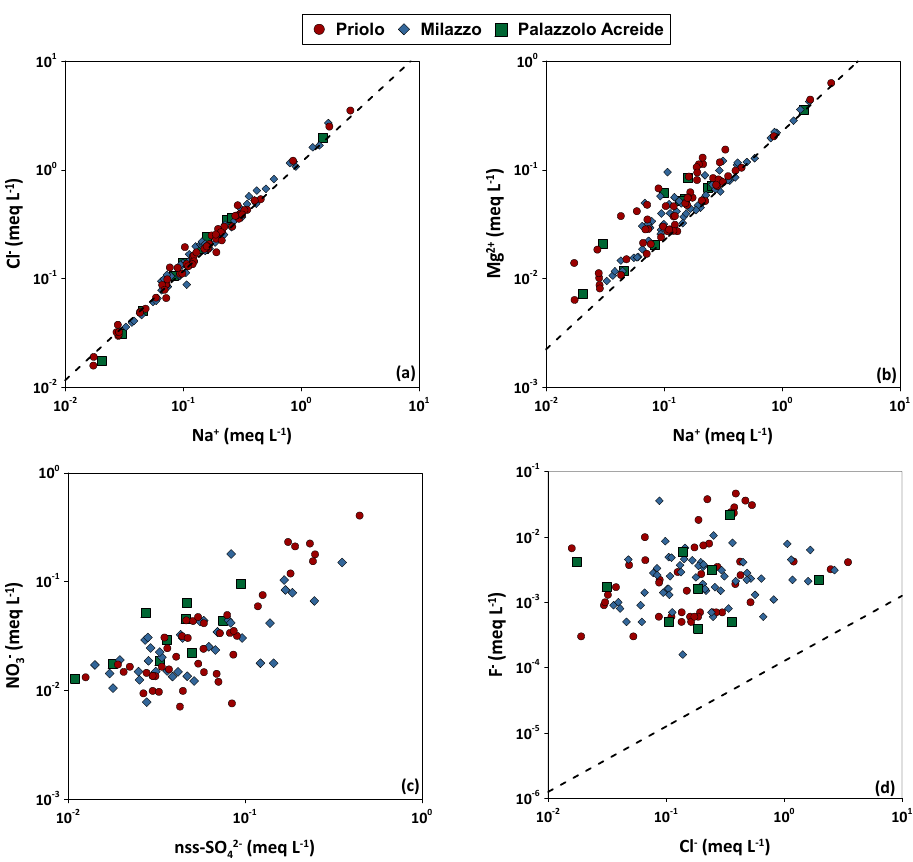
Figure 9. Correlations, in (meq L − 1 ), in Priolo, Milazzo, and Palazzolo Acreide study areas, between Na + and Cl − ( a ), Na + and Mg 2+ ( b ), nss-SO 42 − and NO 3 − ( c ), Cl − and F − ( d ). In ( a , b , d ) the dotted line represents the ratio of ions in seawater (Keene, 1986 [9]).